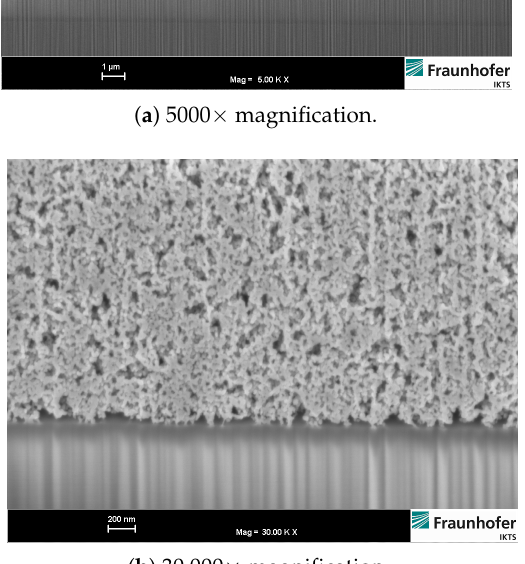
Figure 5. ITO thick film, FESEM images of cross sectional area prepared by focused ion beam (FIB)